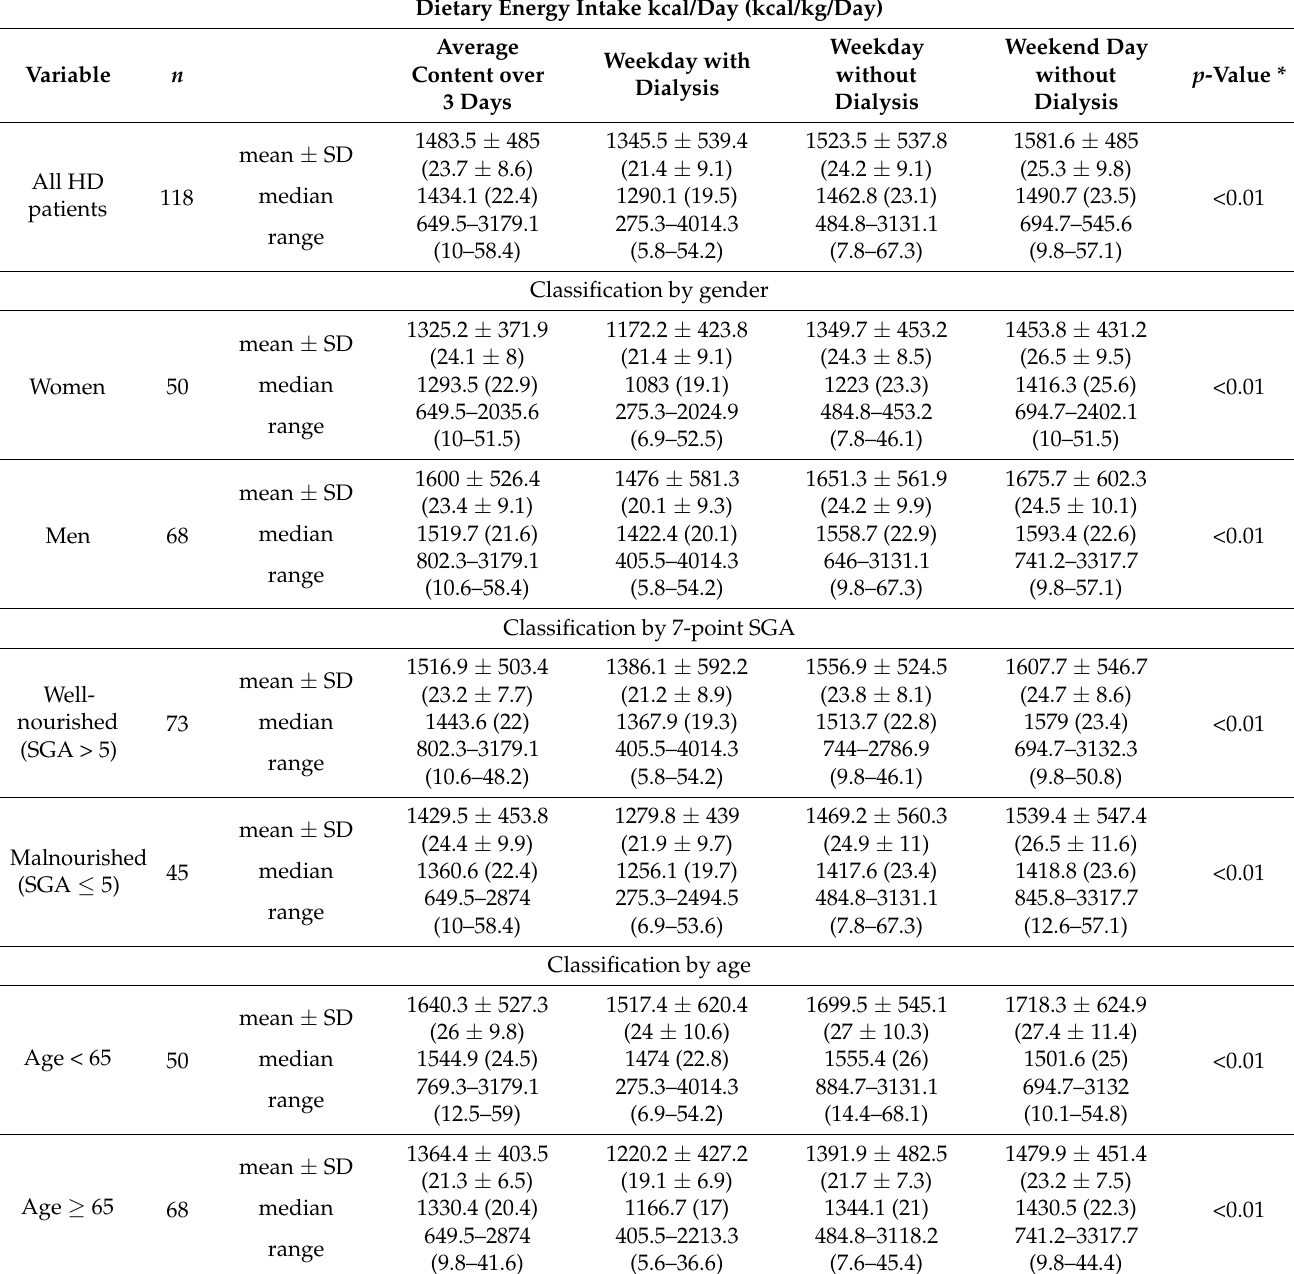
Table 3. Comparison of dietary energy intake on a weekday with dialysis, a weekday without dialysis, and a weekend day without